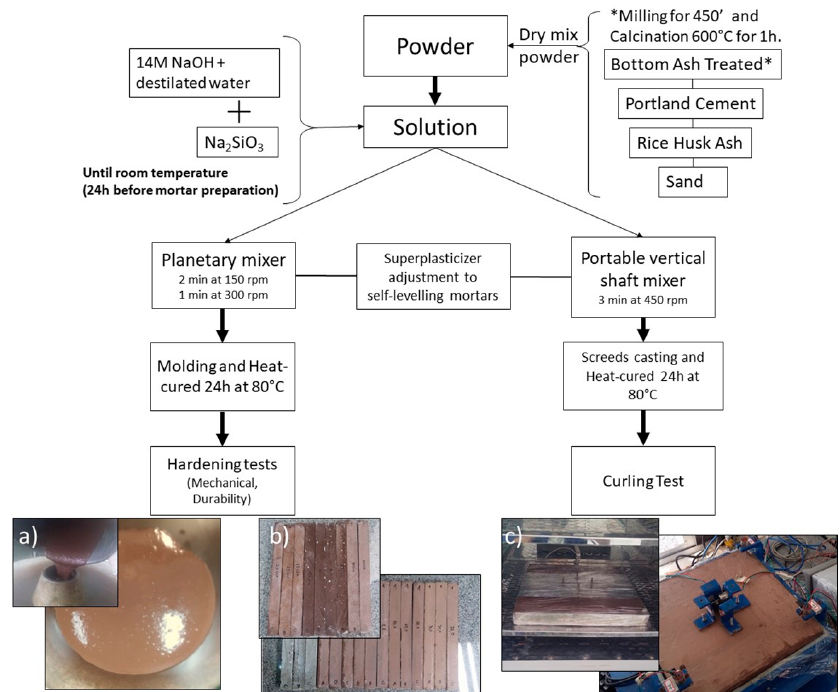
Figure 1. Experimental procedure schema: ( a ) mini-slump flow and self-levelling mortar (spread); ( b ) linear shrinkage bar tests with binary samples (up) and ternary samples (down); ( c ) heat cure of screeds of and curling test.